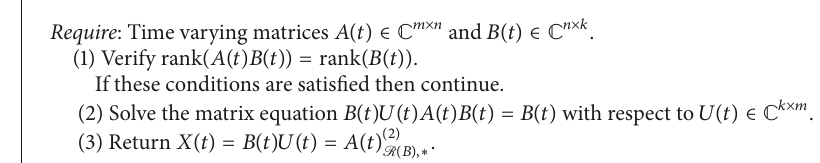
Require : Time varying matrices 𝐴(𝑡) ∈ C 푚×푛 and 𝐵(𝑡) ∈ C 푛×푘 .